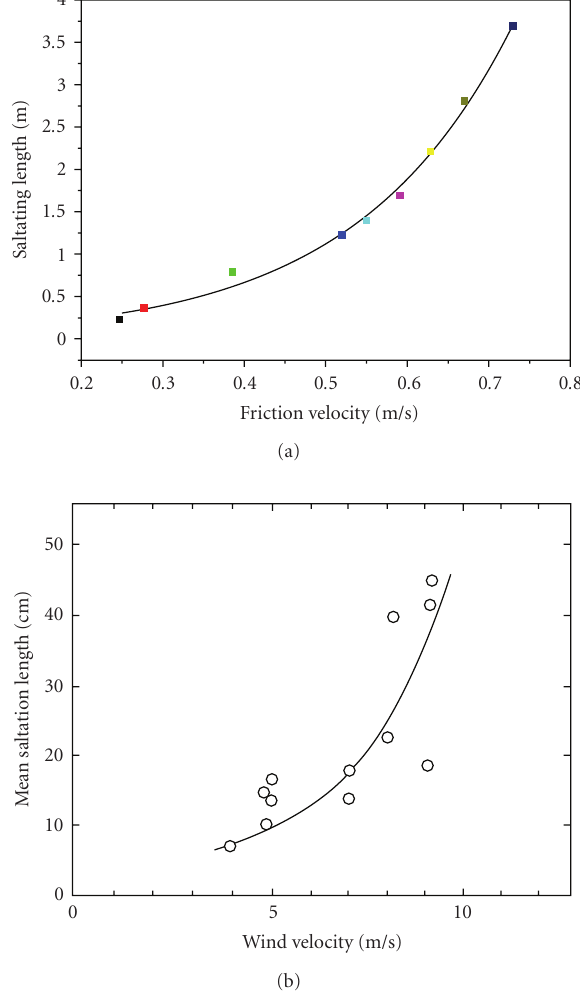
Figure 7: (a) Our results for trajectory length versus friction velocity. (b) The experimental result of Maeno et al. [8].